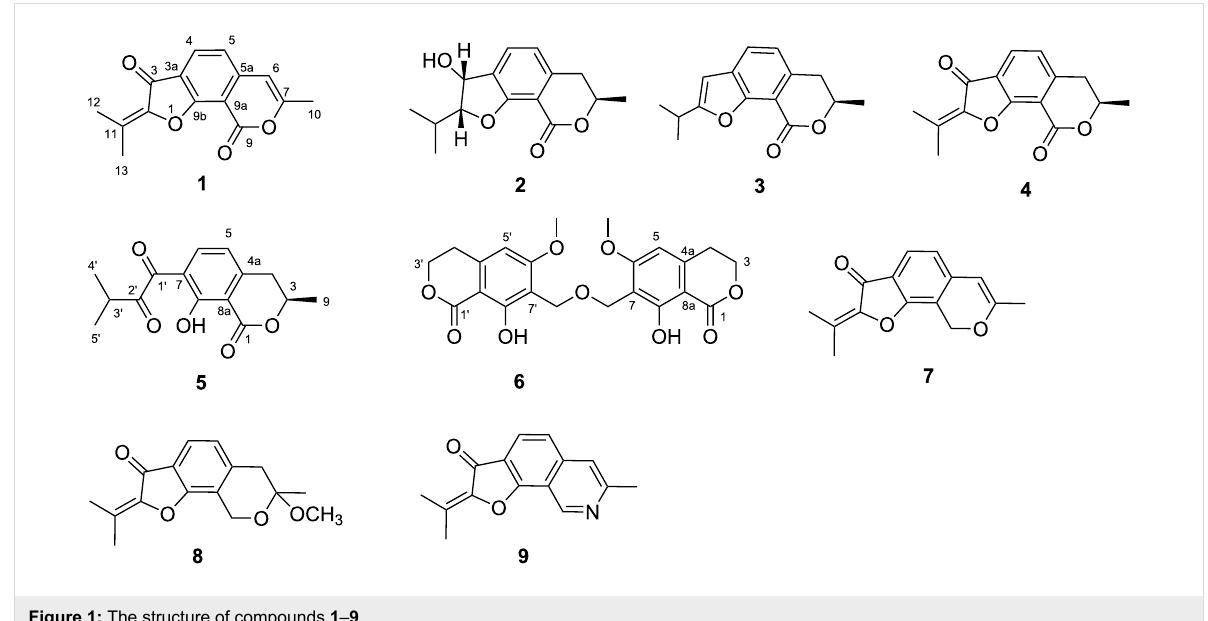
Figure 1: The structure of compounds 1 – 9